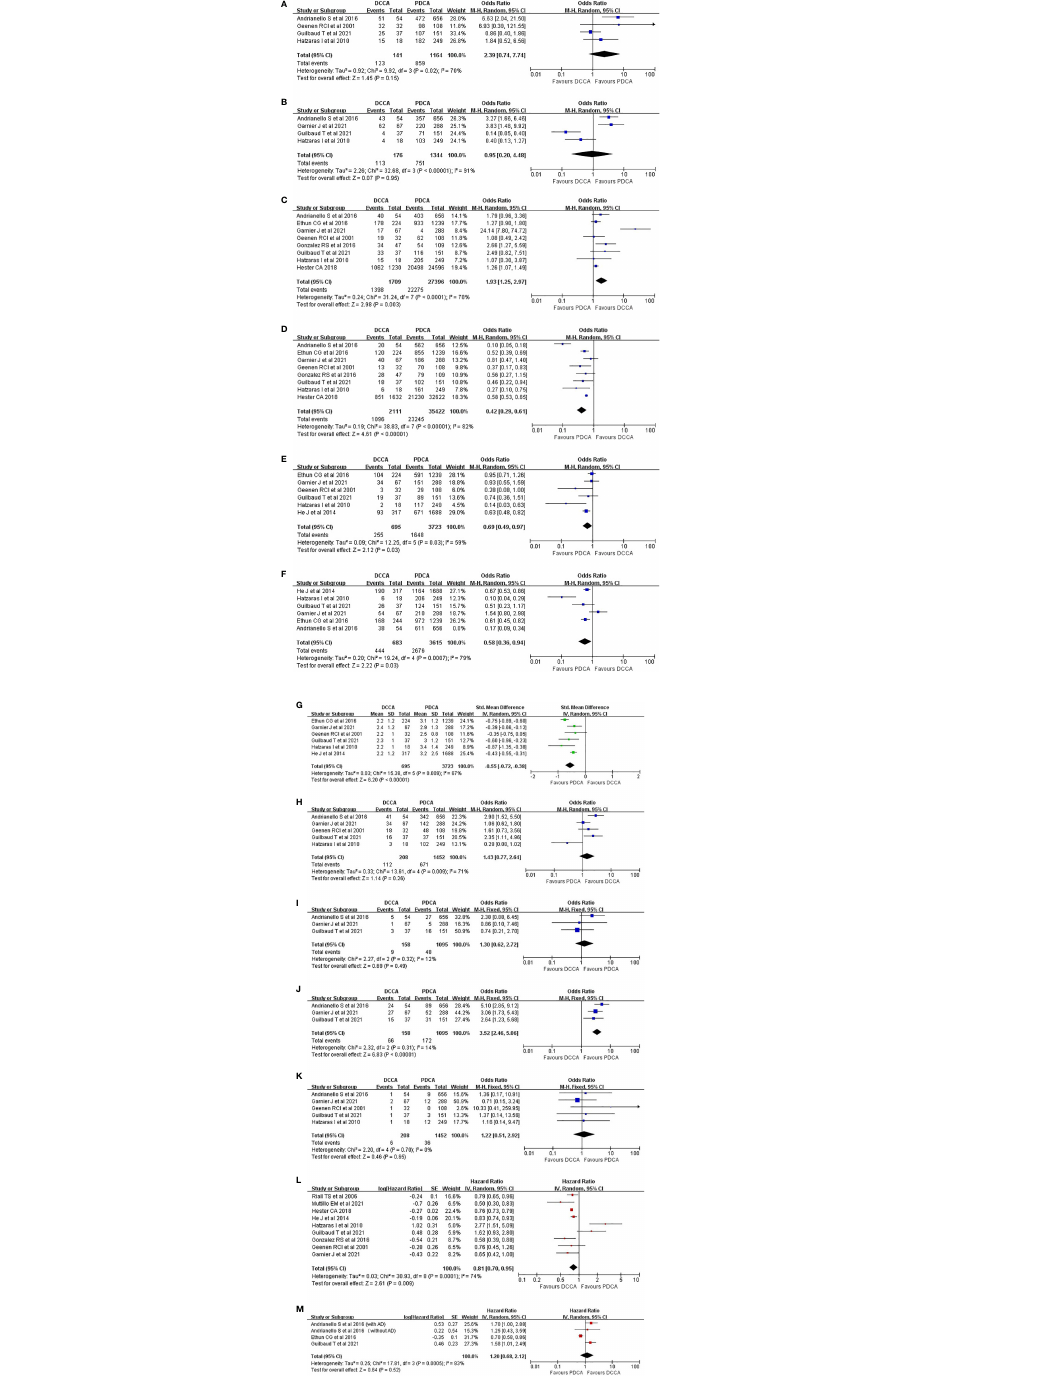
FIGURE 2 Pooled results regarding the tumor clinical-pathological features and long-term prognosis between DCCA and PDCA. (A) Preoperative jaundice. (B) Preoperative stenting. (C) R0 rate. (D) Lymph node metastasis. (E) Vascular invasion. (F) Neural invasion. (G) Tumor size. (H) Postoperative morbidities. (I) Postoperative biliary fi stula. (J) Postoperative pancreatic fi stula. (K) Mortalities. (L) Overall survival. (M) Disease-free survival. DCCA, distal cholangiocarcinoma; PDCA, pancreatic ductal